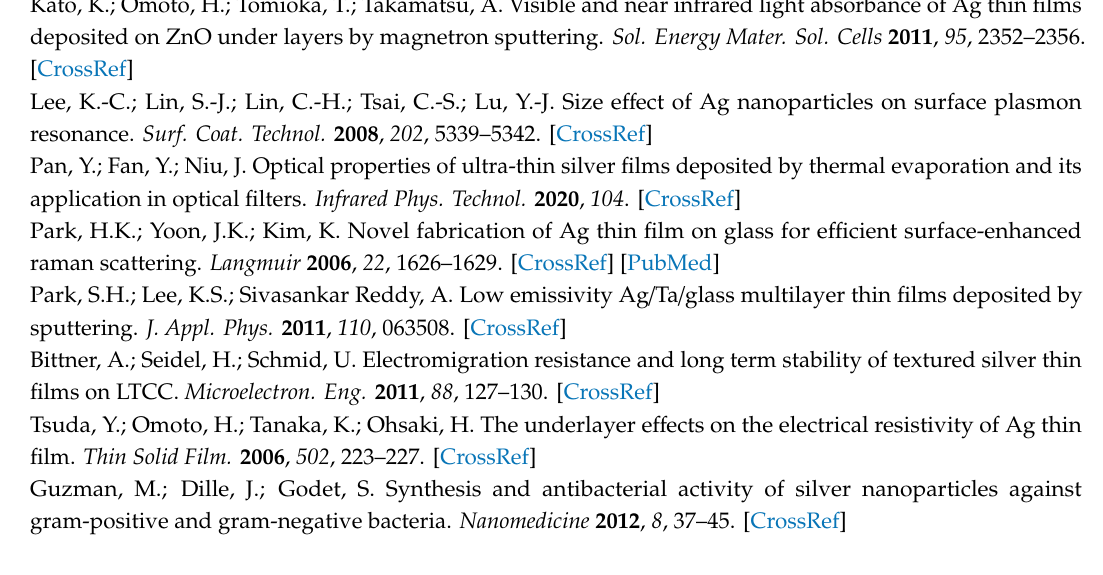
Figure S1: Gaussian graph for Ag nanoparticles size distribution under each capture